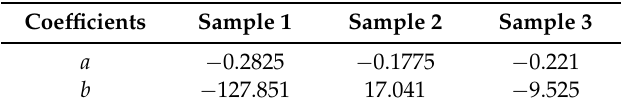
Table 5. Coefficient a and b of DGM(2,1) in three practical